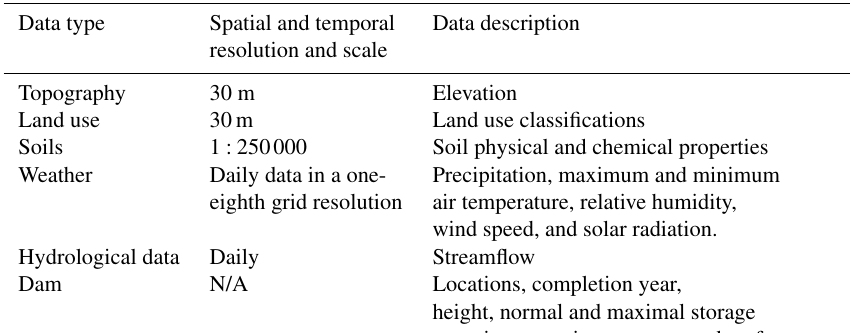
Table 2. Dataset used in the SWAT simulations. n/a – not applicable.